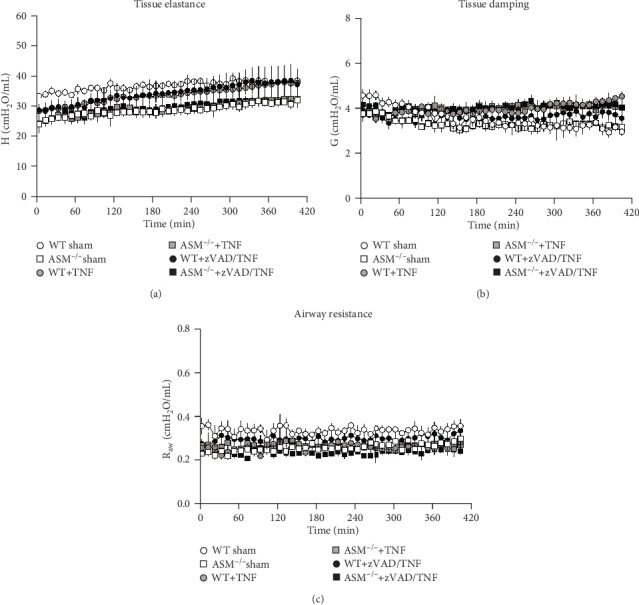
Lung mechanics. (a) Tissue elastance (H), (b) tissue damping (G), and (c) airway resistance (Raw) were measured by the forced oscillation technique every ten minutes. Data are shown as mean ± SEM with ASM−/− sham n = 6 and n = 5 in all other groups.